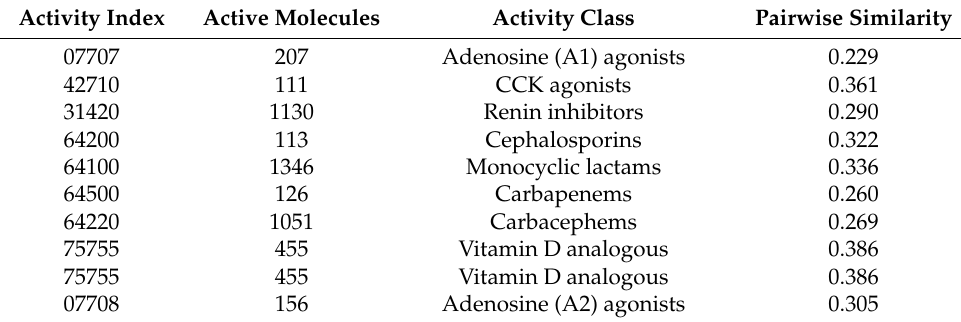
Table 2. The MDDR-DS2 structure activity classes.